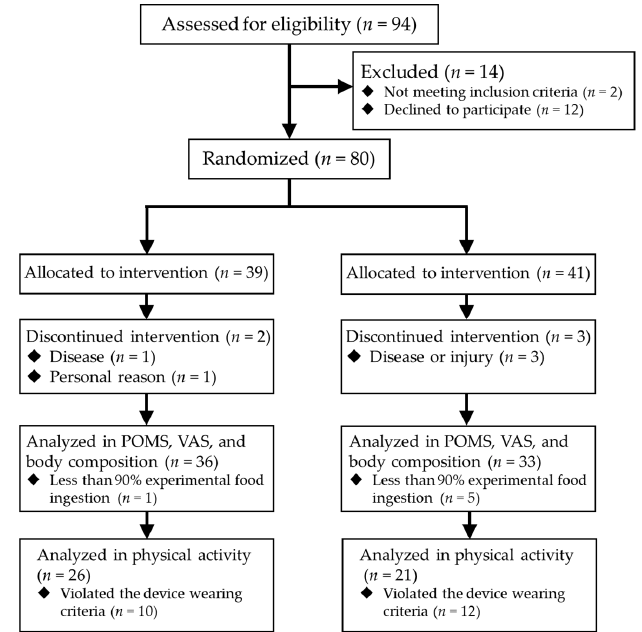
Figure 1. The flow and numbers of the participants.